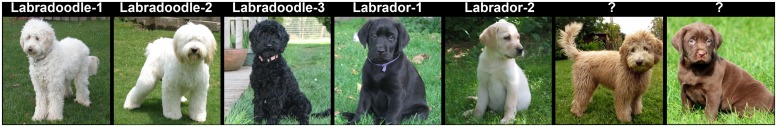
Learning to categorize puppies by comparing and contrasting paired-examples. The most salient feature dimensions differentiating the seven puppies are fur color and fur length. Being informed that two puppies are from the same category can be useful for detecting which feature dimension is most important for categorization. For example, comparing Labradoodle-3 with Labradoodle-1 or Labradoodle-2, or Labrador-1 with Labrador-2, while being informed about their categorical relation, is informative for learning that salient differences in fur color are not important for categorizing these dogs, and thus fur length is more likely to be important. On the other hand, comparing Labradoodle-1 with Labradoodle-2 does not enable inferring which feature is most important. Being informed that two puppies are from distinct categories is also useful forVCL, enabling detecting differences between categories. For example, comparing Labradoodle-3 with Labrador-1, or Labrador-2 with Labradoodle-1 or Labradoodle-2, is informative by highlighting the between categories differences in fur length. On the other hand, comparing Labradoodle-3 with Labrador-2, or Labrador-1 with Labradoodle-1 or Labradoodle-2, is less informative since such comparison is less constraining, enabling deducing that fur color and/or fur length are important for categorization.The labeled examples allow learning that fur length is most relevant for categorization, which in turn allows properly categorizing the two rightmost puppies despite their distinct color(see (see Hammeret al., 2008 for a formal discussion).